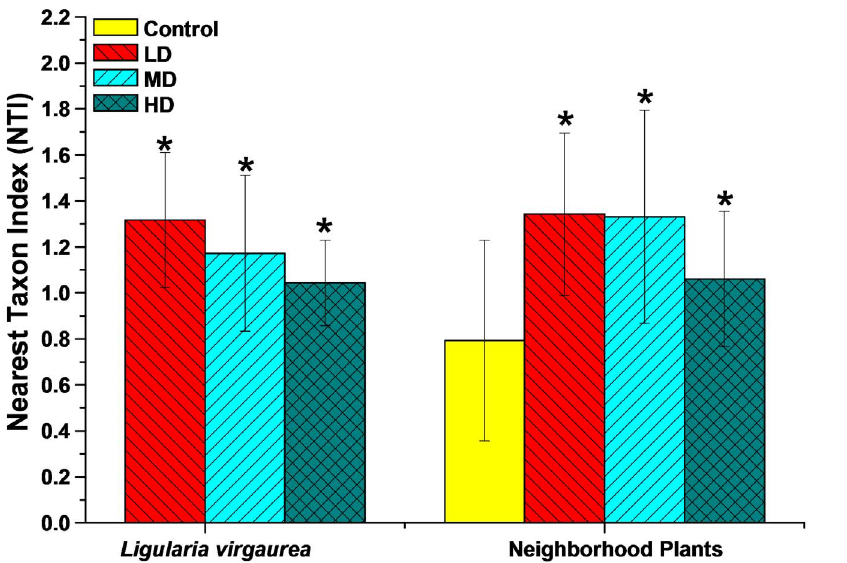
Figure 3. Nearest taxon index (NTI, mean ± SE) of arbuscular mycorrhizal fungal community in the roots of Ligulariavirgaurea and its neighborhood plants in different patches. Mean NTI is significantly higher than zero, indicating that the community is more phylogenetically clustered than expected by chance. Asterisk indicates that the NTI has significant differences with zero at 95% confidence level ( P # 0.05). Control, LD, MD and HD represent no L. virgaurea , low density, moderate density and high density of L. virgaurea , respectively.